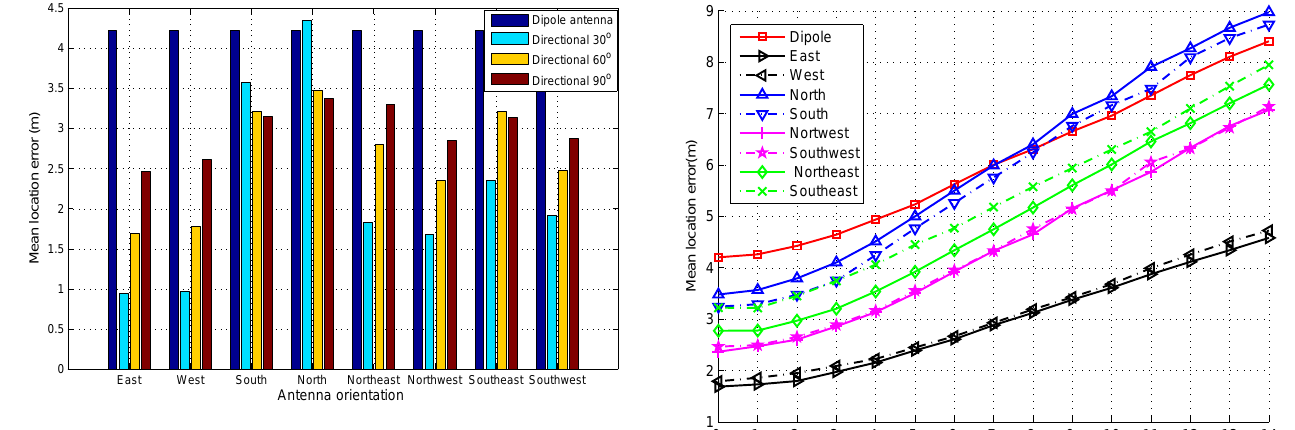
Figure 4: Mean location error versus different an- tennas.